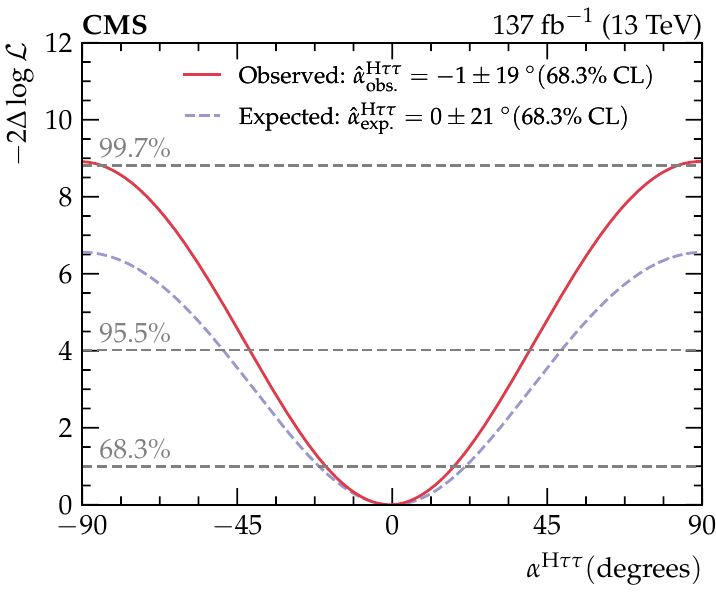
, t t h , and t h t h channels. e t h m